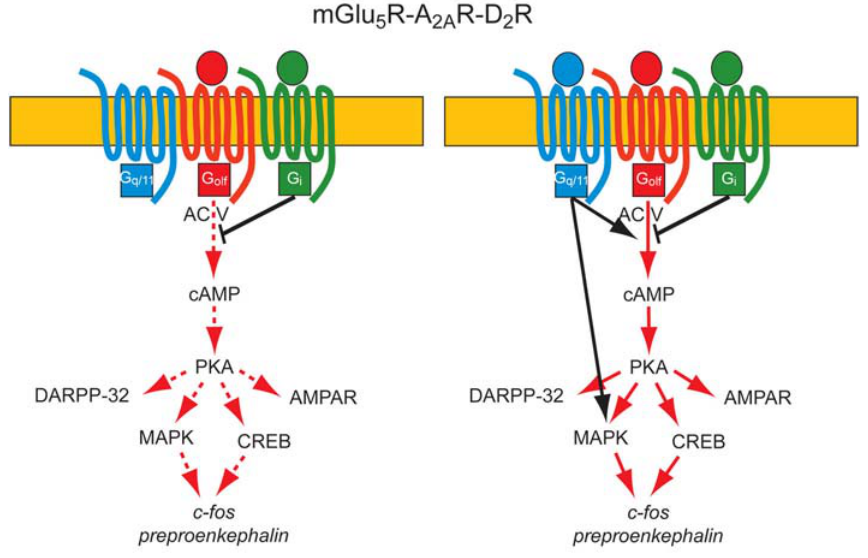
FIGURE 4. Metabotropic glutamate mGlu 5 -adenosine A 2A -dopamine D 2 receptor heteromers. Under basal conditions, in the striatum, stimulation of A 2A receptors can poorly activate cAMP-PKA signaling and increase gene expression, due to a strong tonic inhibitory effect of endogenous dopamine and D 2 receptor stimulation on adenylyl-cyclase. The mGlu 5 receptor heteromerizes and functionally interacts with the A 2A receptor. By potentiating the effects of A 2A receptor on adenylyl-cyclase and MAPK activation, mGlu 5 receptor coactivation allows the A 2A receptor to counteract the inhibitory effect of D 2